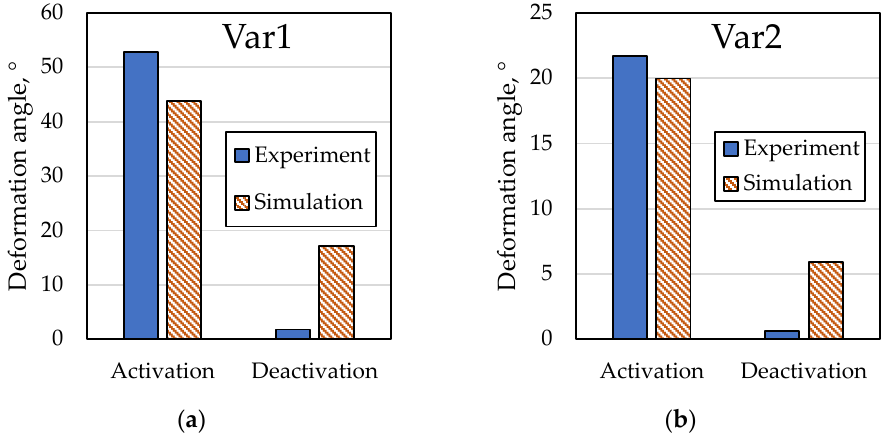
Figure 18. Comparison of deformation angles of simulation and experiment of ( a ) Var1 and ( b ) Var2.